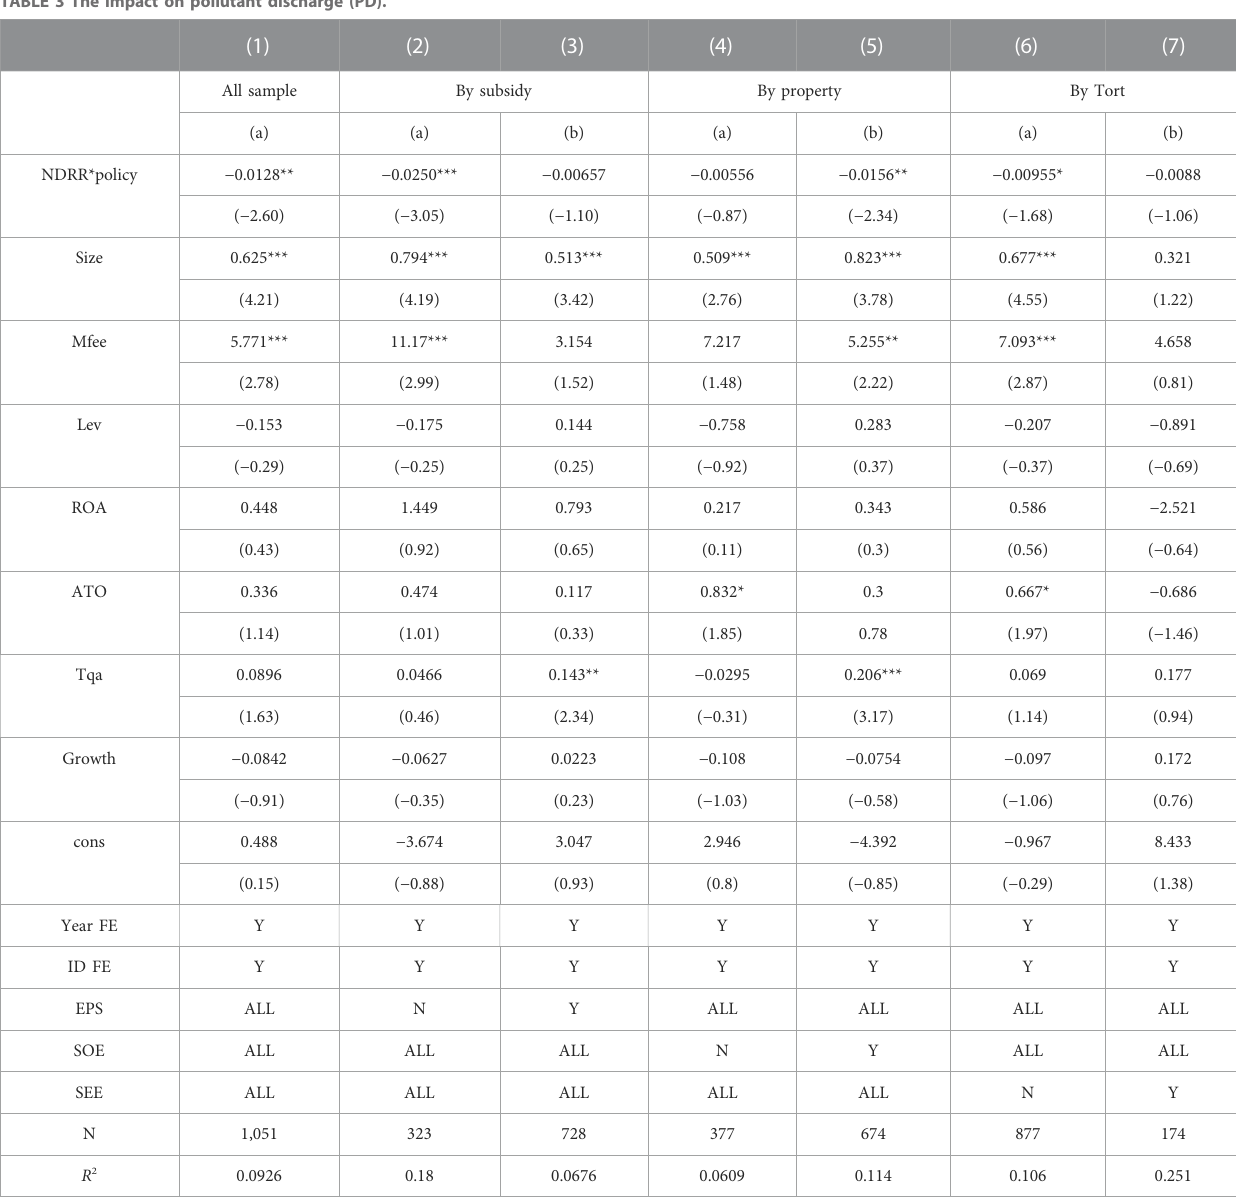
TABLE 3 The impact on pollutant discharge